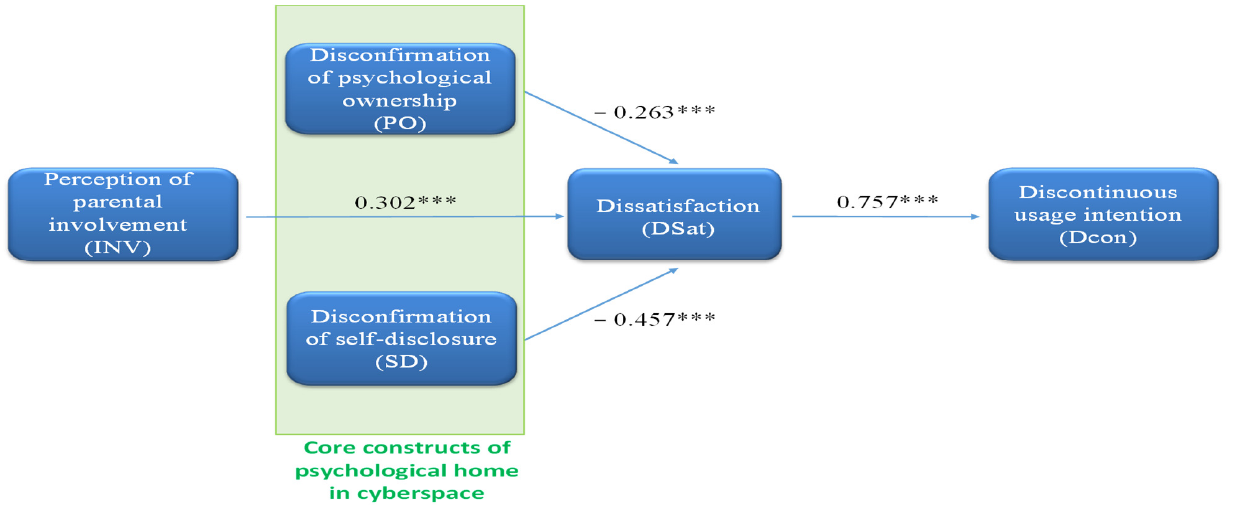
Figure 2. PLS structural model (*** p -value < 0.001). Table 6. Path coefficients of the model.